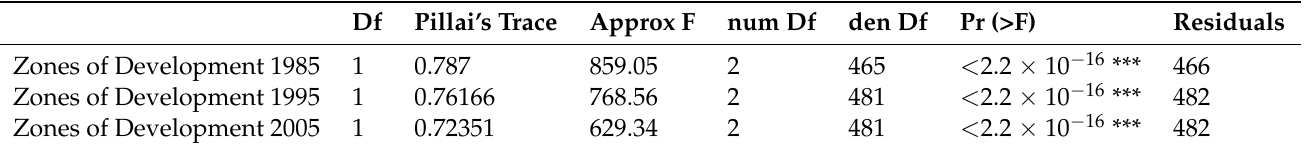
Table 4. Multivariate Analysis of Variance (MANOVA) test for the zones of developments.